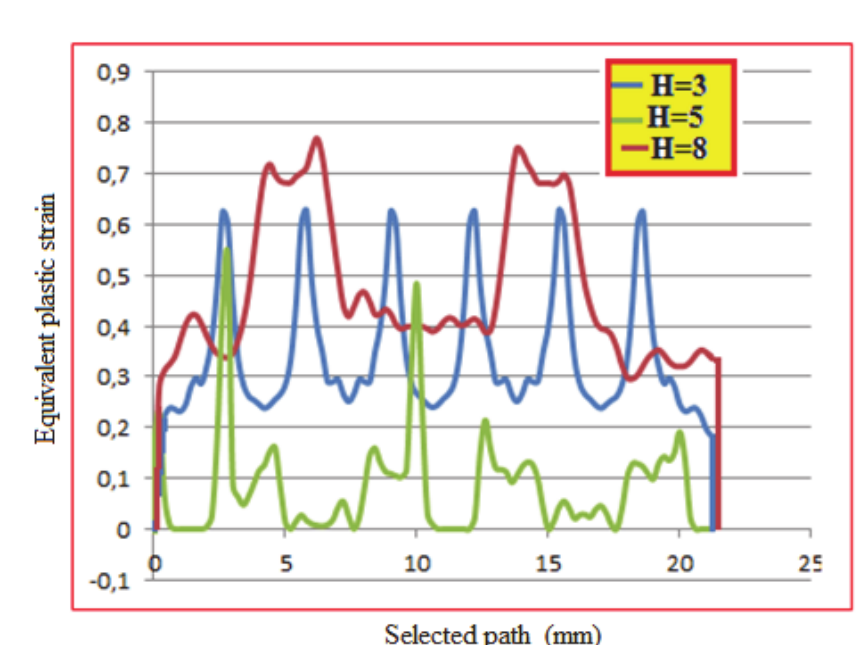
Figure 19: Evolution of equivalent plastic deformation along a path on the middle of the sample using different groove depths.